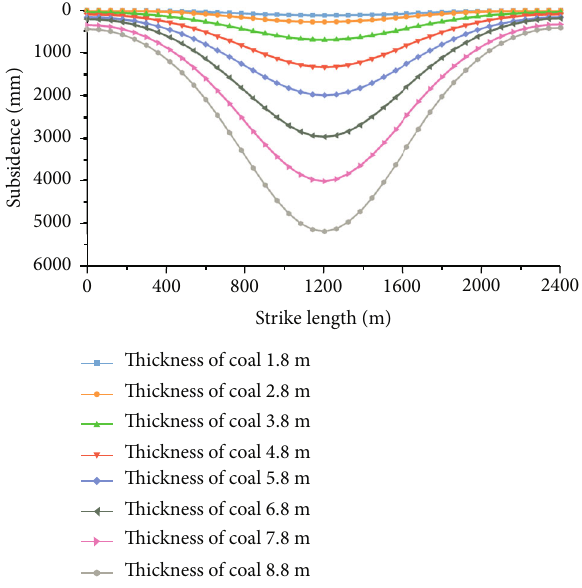
Figure 10: Surface subsidence curve in strike direction with di ff erent thickness of